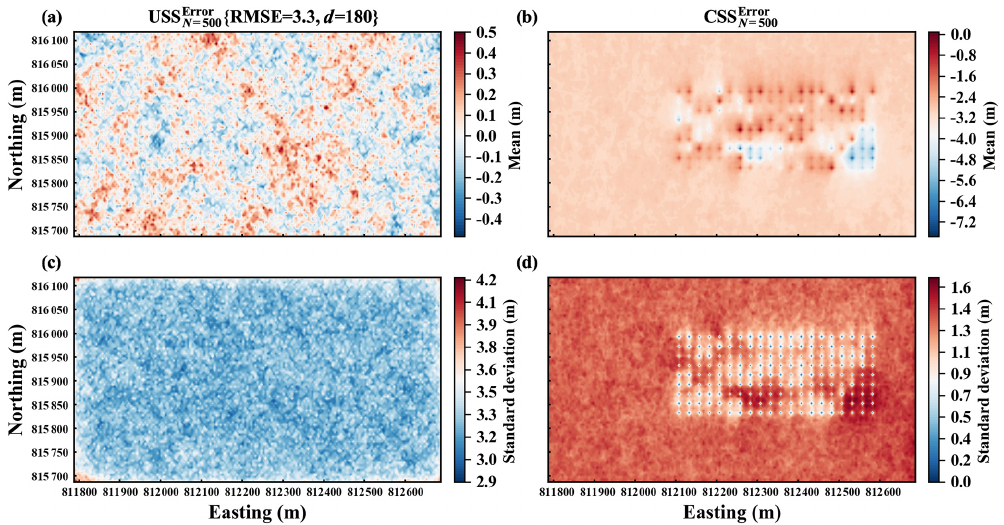
Figure 6. Statistics of HK-DTM error realizations. (a) Mean and (c) standard deviation grid of USS Error mean and standard deviation values are centered around 0 and 3.3m. (b) Mean and (d) standard deviation grid of CSS Error values at grid points away from the reference locations are centered around the mean ( µ ) − 3 . 0m of (cid:15) ∗ { K = 180 } at the reference locations. The standard deviation values at grid points away from the reference locations are centered around (cid:15) ∗ KK { K = 180 } and vanish at the reference locations. This matches the assumptions underlying USS and the standard deviation ( σ ) 1 . 5m of (cid:15) ∗ KK CSS as introduced in Sect.